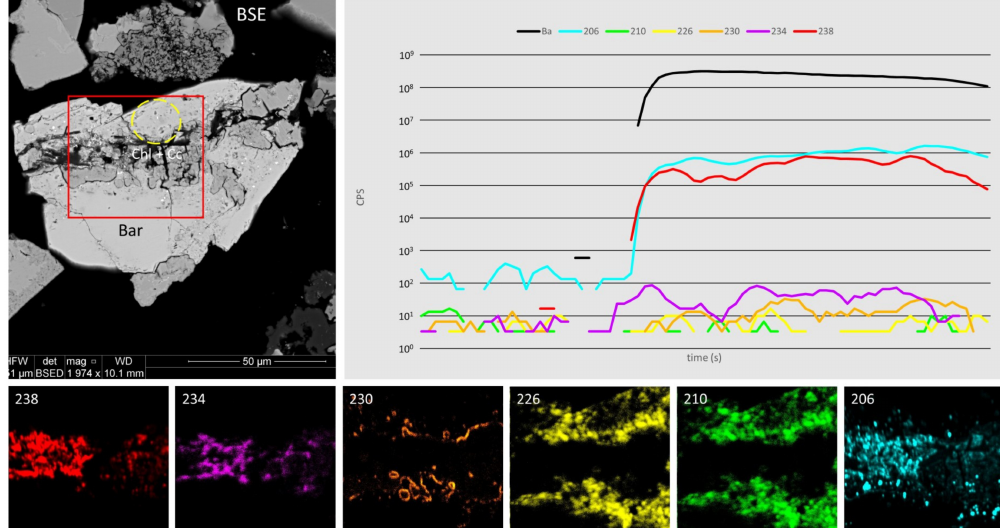
Figure 13. The BSE image (top left), single time-resolved LA-ICP-MS depth profile data (top right), and nanoSIMS images (bottom) of assemblage in sample 02CLD29 (chalcocite / chlorite ‘vein’ crosscutting baryte (Bar) with abundant inclusions). Maps of 206 Pb, 210 Pb, 226 Ra, 230 Th, 234 U, and 238 U are presented. The red outline is the nanoSIMS mapping area, the yellow circle represents the location of the 15 µ m-diameter LA-ICP-MS spot. Uranium is concentrated within the vein, whereas 210 Pb, Ra, and Th appear preferentially enriched in baryte containing abundant, dense inclusions. Lead-206 likely has multiple origins and is found throughout. Pristine baryte (lower left of the nanoSIMS maps) contains virtually no